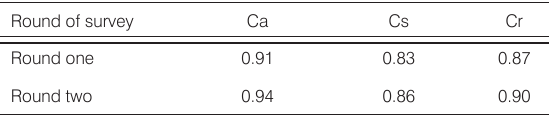
Table 5. Study on the eligibility criteria and training content for prescriptive authority for midwives